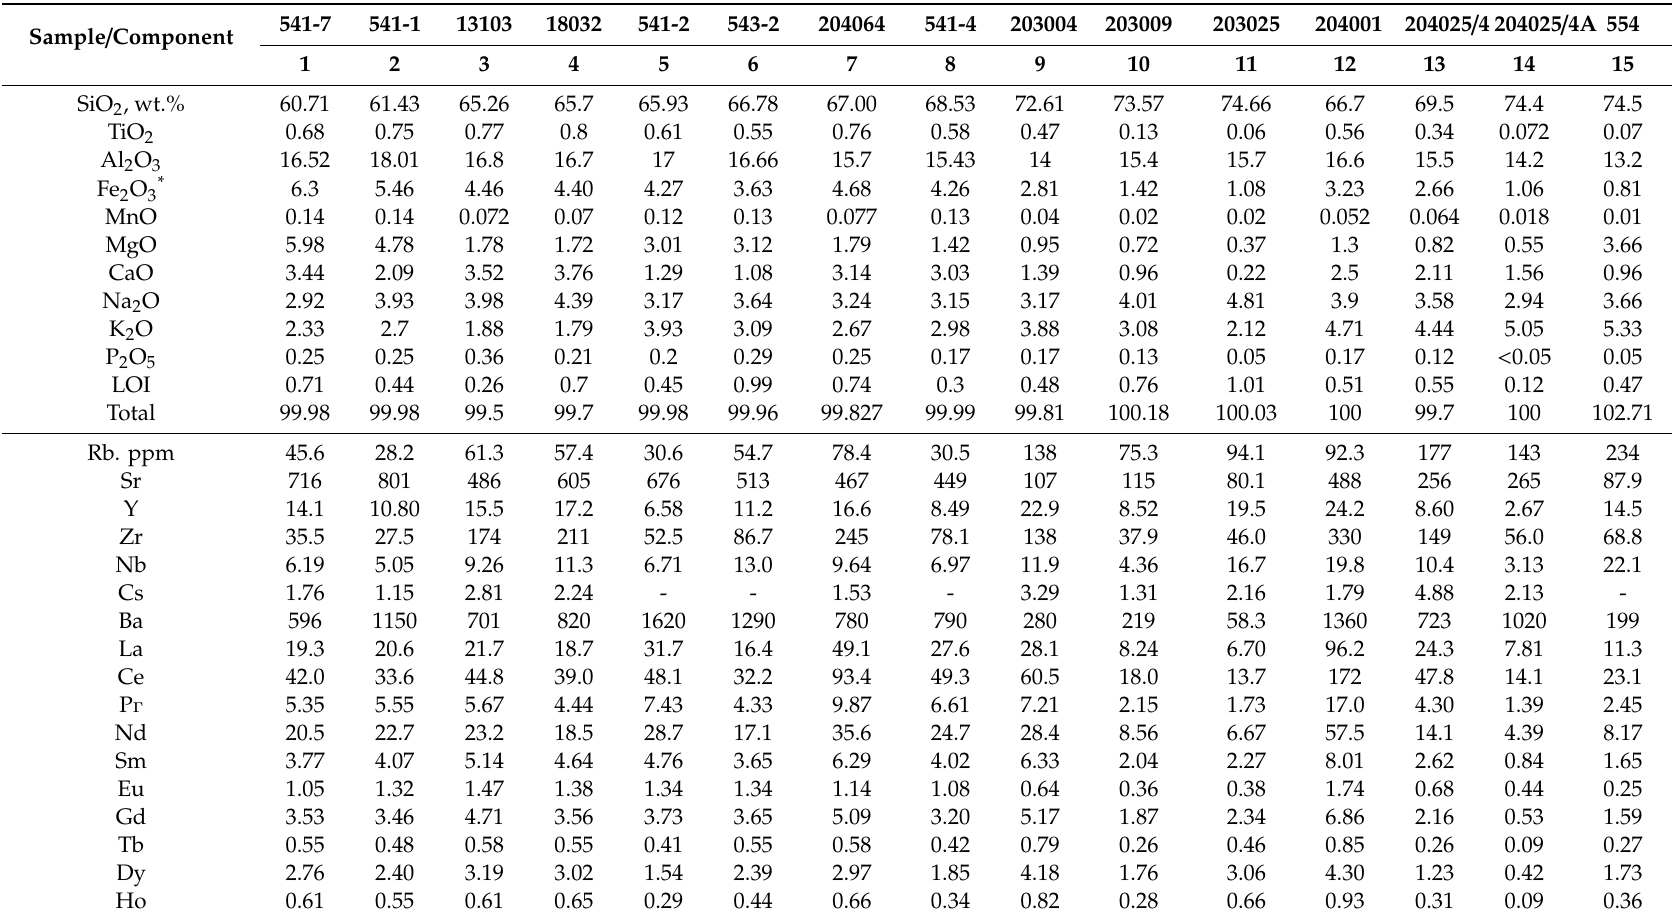
Table A2. Results of X-ray fluorescence and ICP-MS analyses for the studied